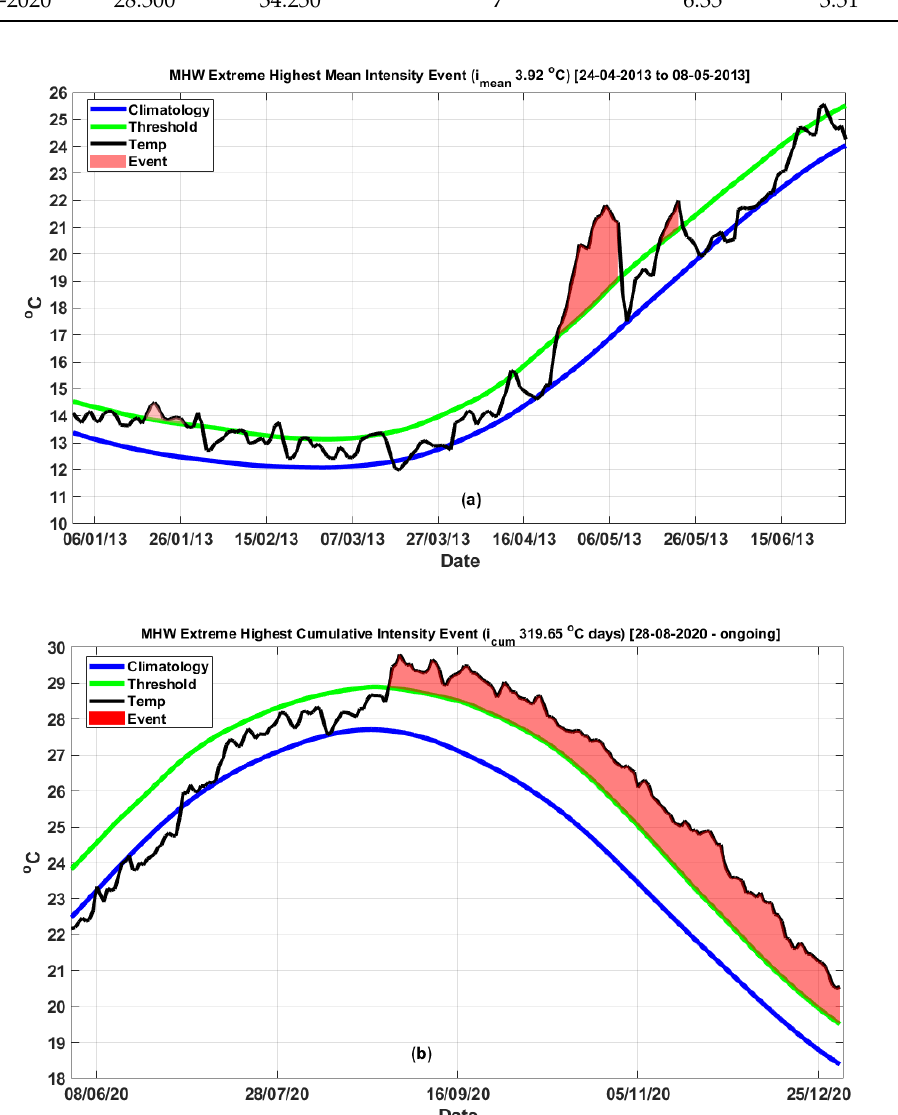
Figure 11. The EMED extreme MHW significant events over the study period (1982–2020), The SST climatology from NOAA OI SST for the detection of MHWs (blue), 90th percentile MHW threshold (green), and SST time series (black) for each MHW. The pink filled area indicates the period associated with the identified MHW, where ( a ) MHW extreme highest mean intensity event (i mean 3.92 ◦ C) (24-04-2013 to 08-05-2013), ( b ) MHW extreme highest cumulative intensity event (i cum 319.65 ◦ C days)